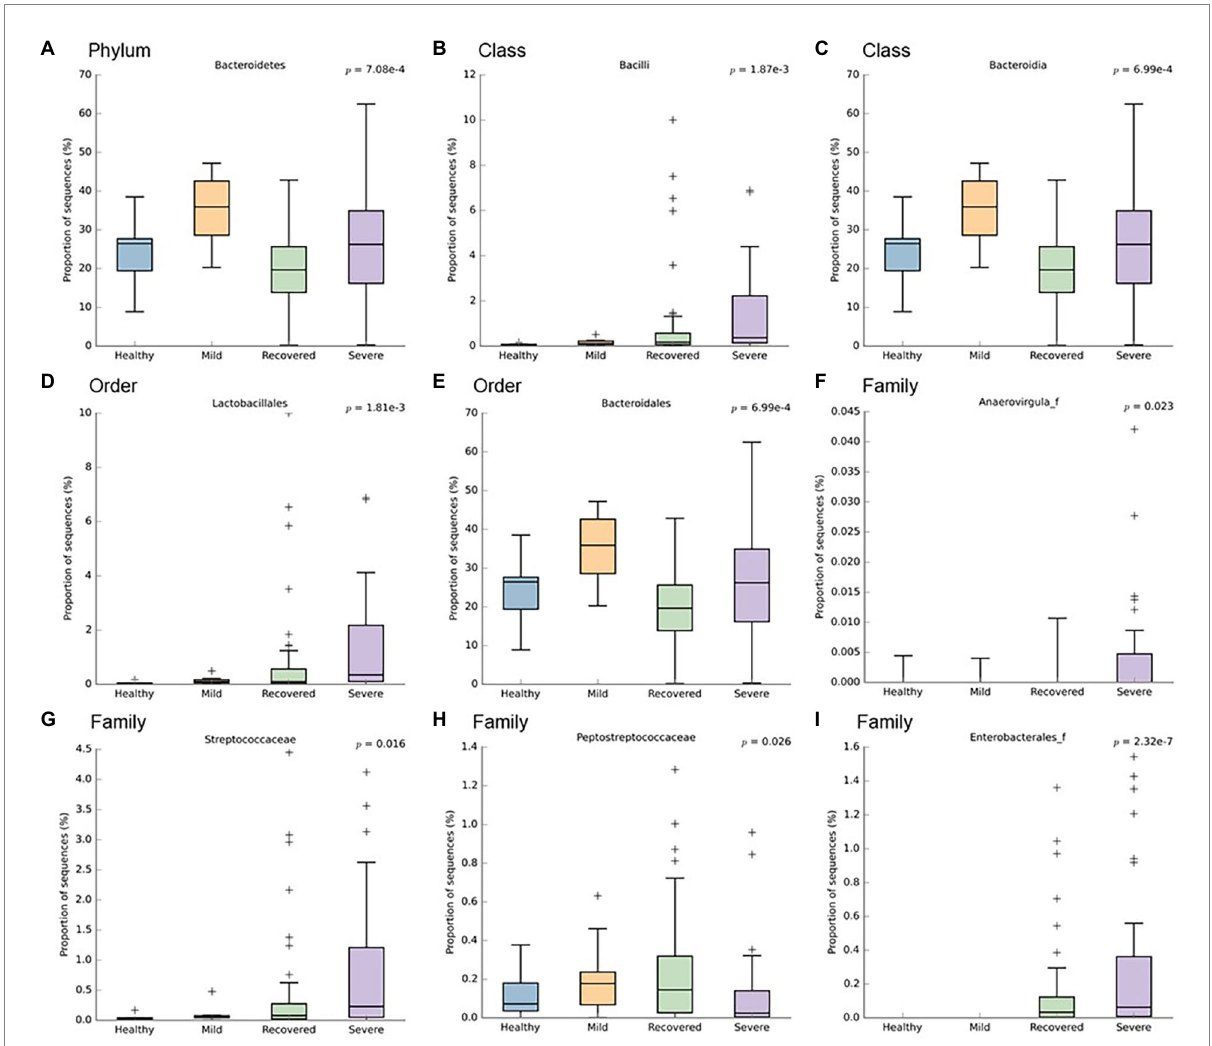
FIGURE 3 Boxplots representing the relative abundance of significant bacteria: (A) Bacteroidetes , (B) Bacilli , (C) Bacteroidia , (D) Lactobacillales , (E) Bacteroidales , (F) Anaerovirgula , (G) Streptococcaceae , (H) Peptostreptococcaceae , (I) Enterobacterales . This analysis was performed with Welch’s t-test and an effect size filter of 0.05, to compare the abundance differences between the study’s